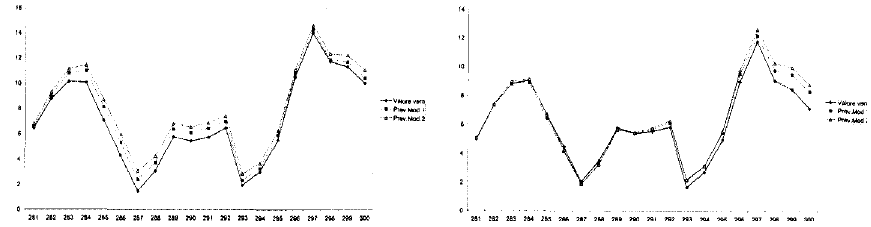
Figure 2 - Control forecasts, eq. 1. Fzguve 3 - Control forecasts, eq. 2